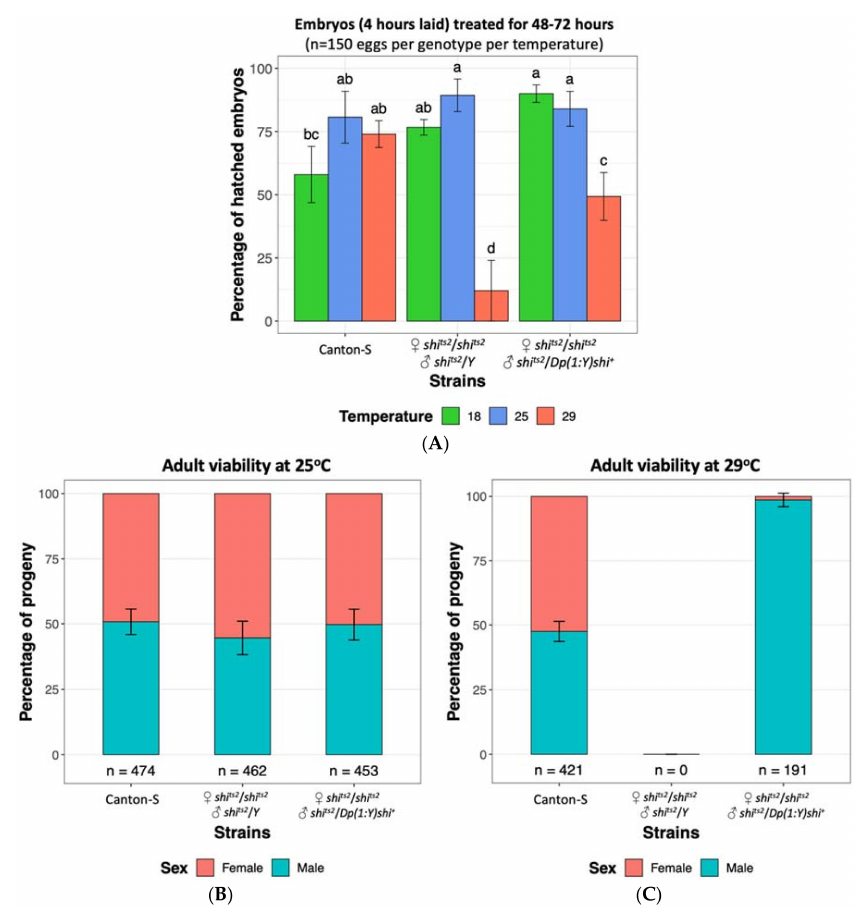
Figure 2. Embryo survival and fly viability at 18 ◦ C, 25 ◦ C and 29 ◦ C of Drosophila melanogaster wild type strain Canton-S shi ts2 / shi ts2 and shi ts2 / Y ) [Bloomington Stock ID [Bloomington Stock ID 64349], temperature sensitive shibire strain shi ts2 ( ♀ ♂ shi ts2 / shi ts2 and shi ts2 / Dp(1:Y)shi + ), generated from crossing shi ts2 2248] and shibire Y-chromosome male rescue strain ( ♀ ♂ and Dp(1:Y)shi + [Bloomington stock ID 4166]. ( A ) Embryos up to four hours old were collected and maintained at 18 ◦ C, 25 ◦ C and 29 ◦ C for 48–72 h. The mean ( ± SD) percentage of hatched embryos from three replicates are shown, with 50 eggs per replicate. Significance was assessed using a two-way ANOVA followed by a Tukey post hoc test. The same letter above each bar indicates no significant difference ( p > 0.05). High embryo mortality rates are observed in the shi ts2 strain at 29 ◦ C. ( B ) All strains tested are viable at 25 ◦ C. ( C ) At 29 ◦ C no survivorship is observed for the shi ts2 strain, unless males carry the Y-chromosome rescue. Data is displayed as a percentage with the total number of flies indicated below each bar. Standard deviations from six to eight replicates are shown (Supplementary Methods